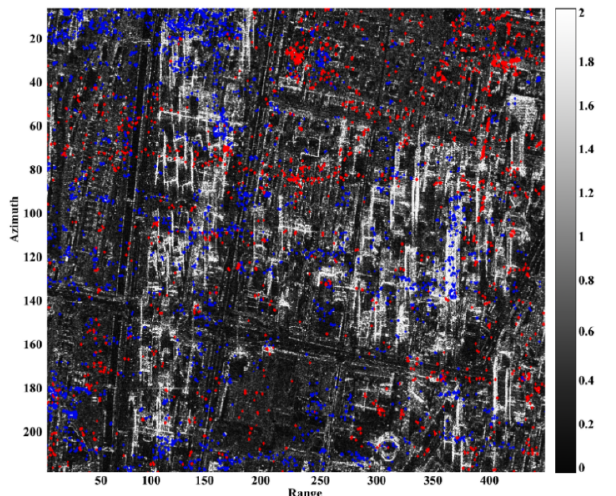
Figure 2. The results of Layover Scatterers Simulation.